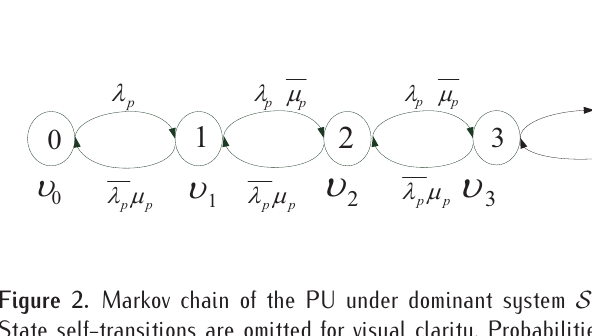
Figure 2. Markov chain of the PU under dominant system S 1 . State self-transitions are omitted for visual clarity. Probabilities μ − μ λ − λ p = 1 p and p = 1 p